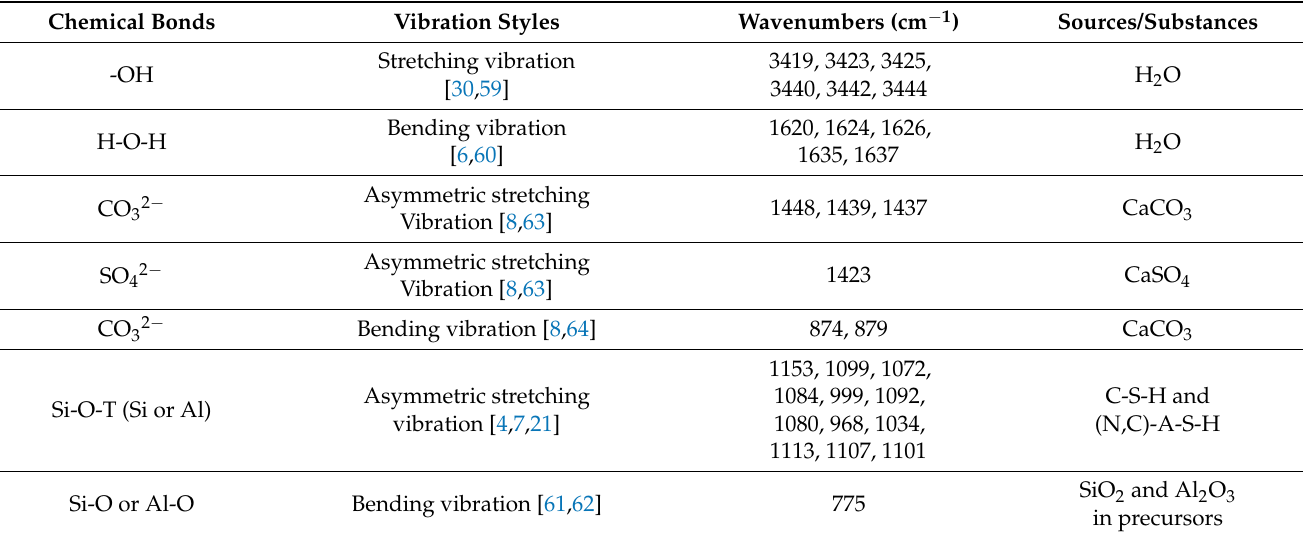
Table 5. The absorption peaks of related chemical bonds by FTIR